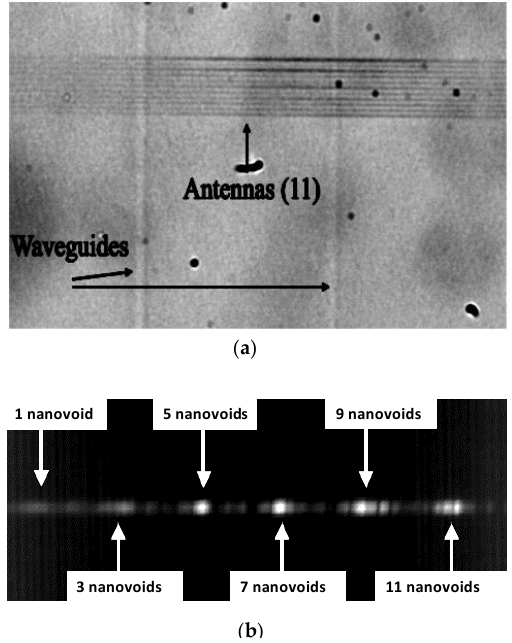
Figure 10. ( a ) Photoinscription of a scattering element, made by a group of 11 Bessel nanovoids (this forms an antenna or mini-diffraction grating) inter-spaced by 3 µm; ( b ) Top-view of the signal scattered by groups of antennas with a different number of Bessel nanovoids.